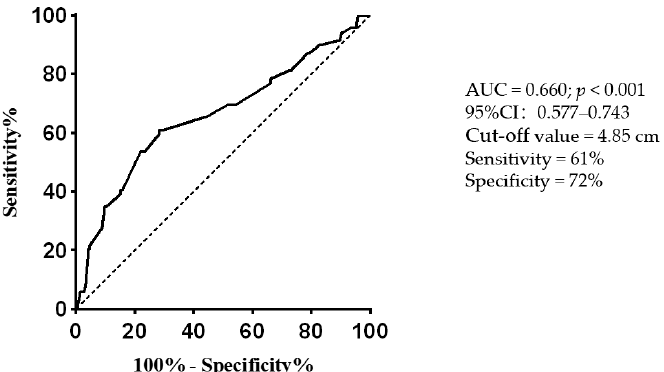
Figure 1. Receiver operating characteristic curve evaluating the diagnostic potential of tumor diameter for predicting PPGLs with negative catecholamines. AUC: area under the curve; PPGLs: pheochromocytomas and paragangliomas.